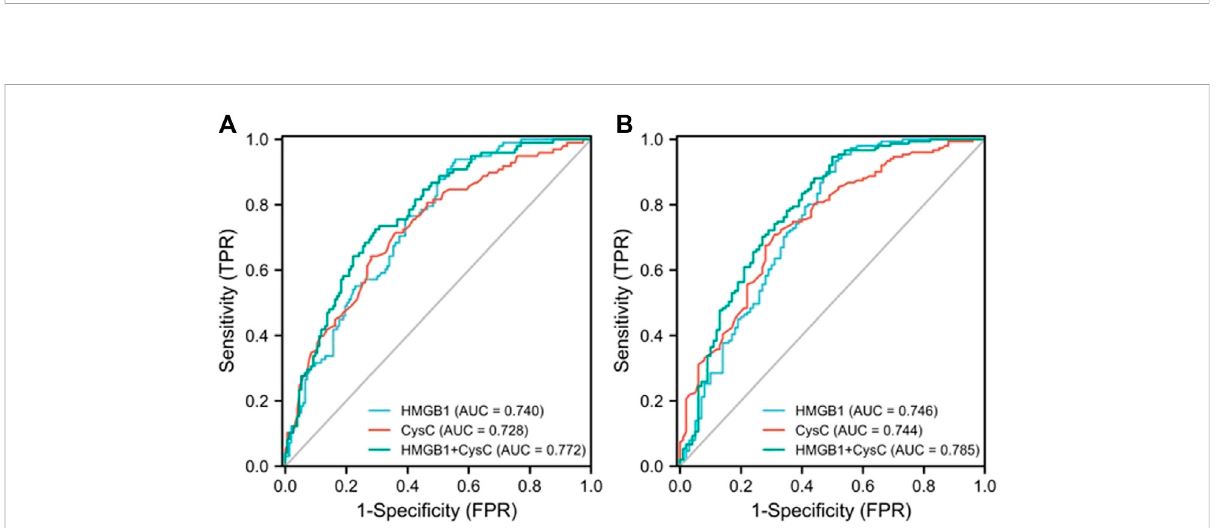
FIGURE 3 AUROCanalysiswasperformedtocomparetheef fi cacyofserumHMGB1andCysClevelsinpredictingthedevelopmentofAKI (A) orsevereAKI (B) in pre-matching HBV-ACLF patients during the 90-day follow-up period (AUROC, area under the receiver operating characteristic curve; HBV- ACLF, hepatitis B virus-related acute-on-chronic liver failure; AKI, acute kidney injury; CysC, cystatin C; HMGB1, high-mobility group box